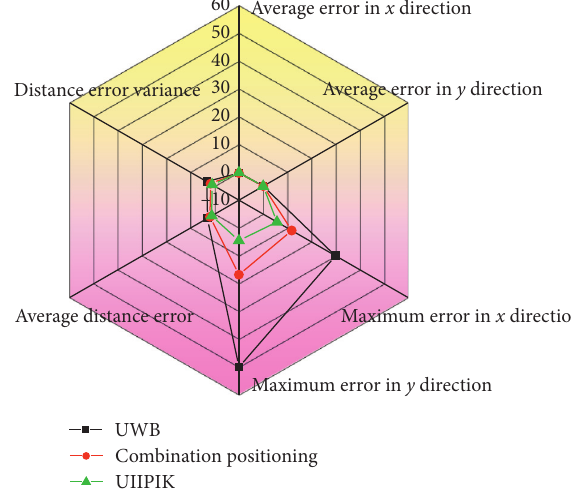
Figure 6: Statistics of positioning error